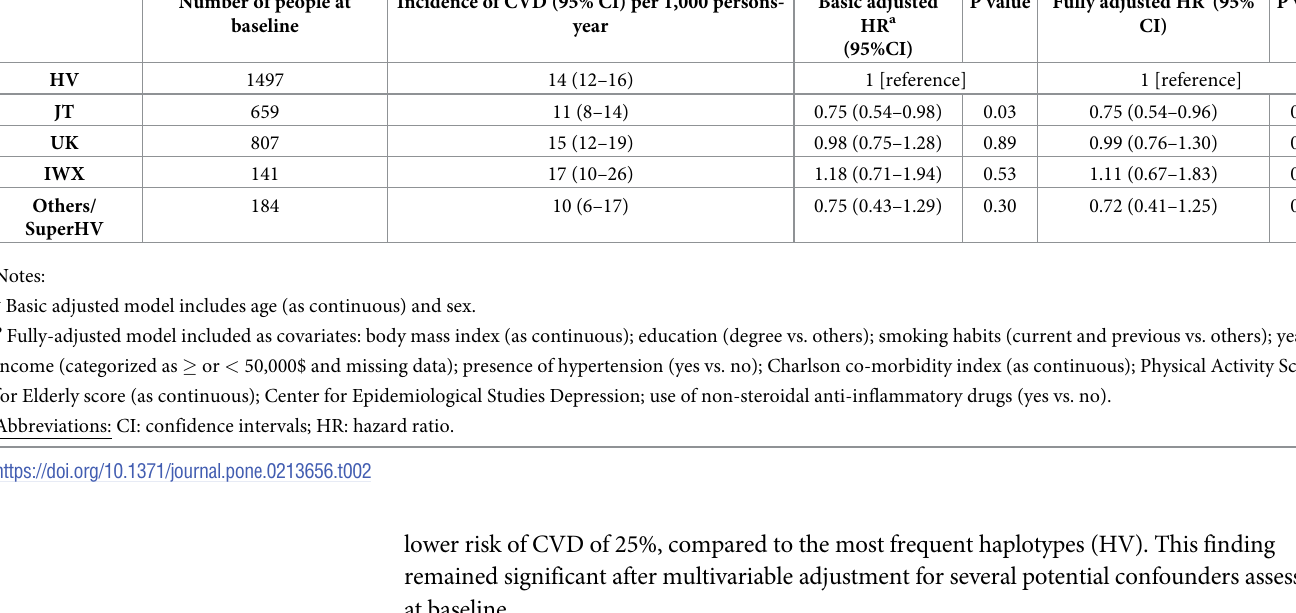
Table 2. Association between mitochondrial haplogroups and incident cardiovascular disease. Number of people at baseline